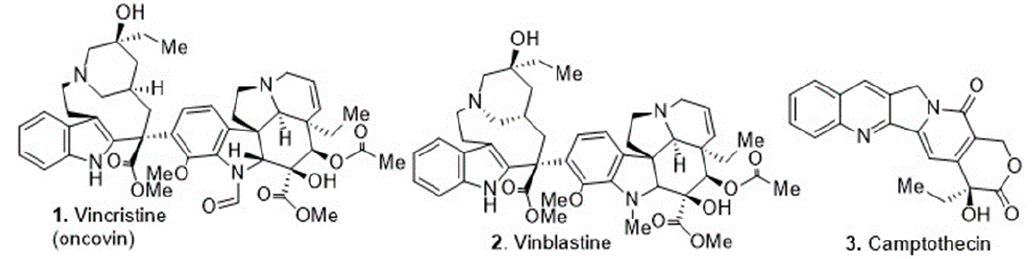
Figure 1. Natural product-derived alkaloids in clinical use.